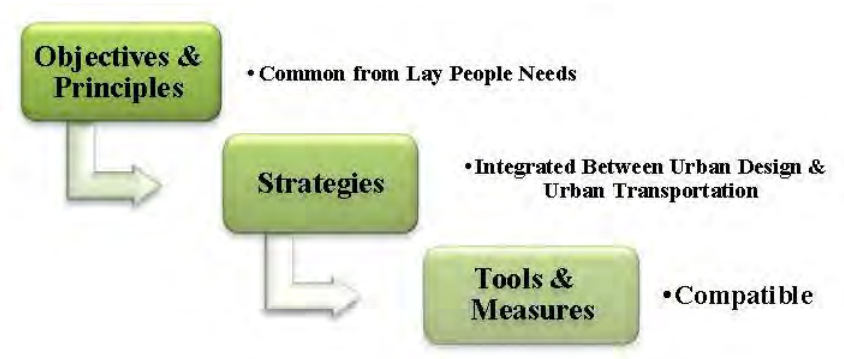
Figure 4. General Idea of the Integration of Urban Design with Urban Transportation. Source: (Mohammed, 2016, p.